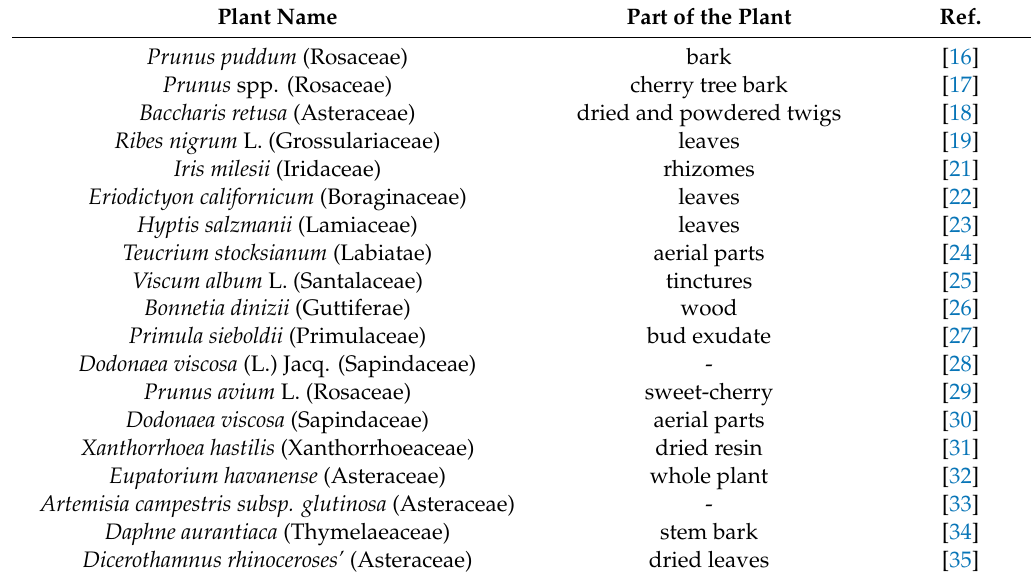
Table 1. The plant sources of sakuranetin.